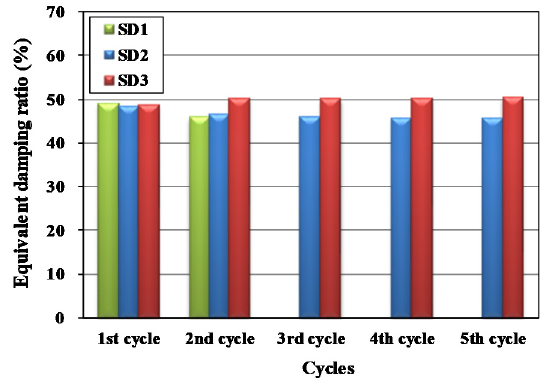
Figure 9. Equivalent damping ratios of specimens for each cycle.